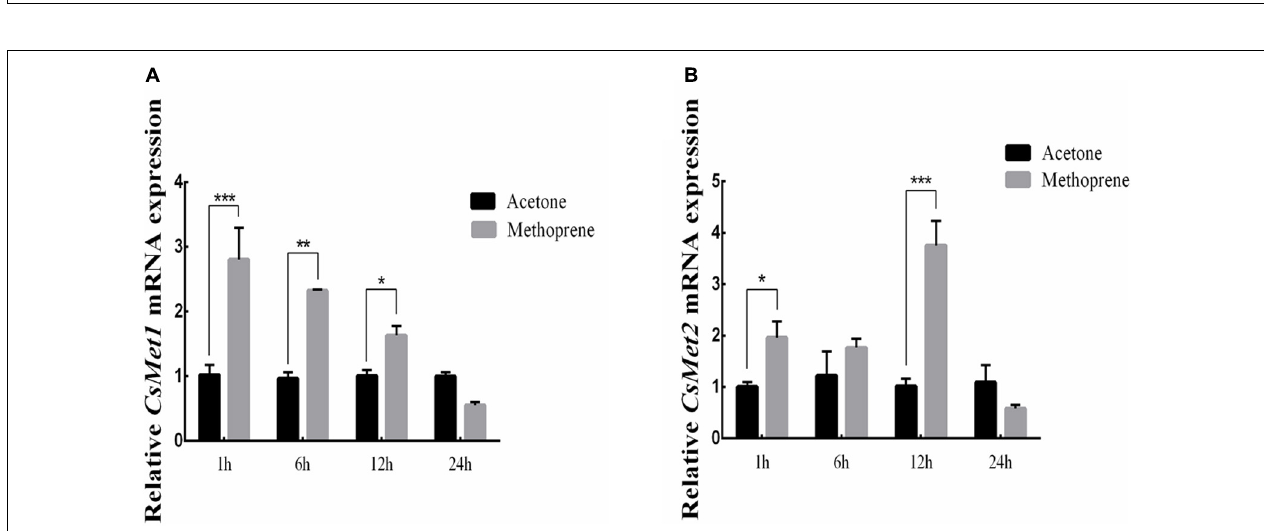
FIGURE 4 | Relative mRNA levels of CsMet1 (A) and CsMet2 (B) in the whole body insects after methoprene treatment in newly emerged female adults. The bars represent mean ± SE of three biological replicates. Asterisks indicate the significant differences between the groups (* P < 0.05, ** P < 0.01, and *** P < 0.001).